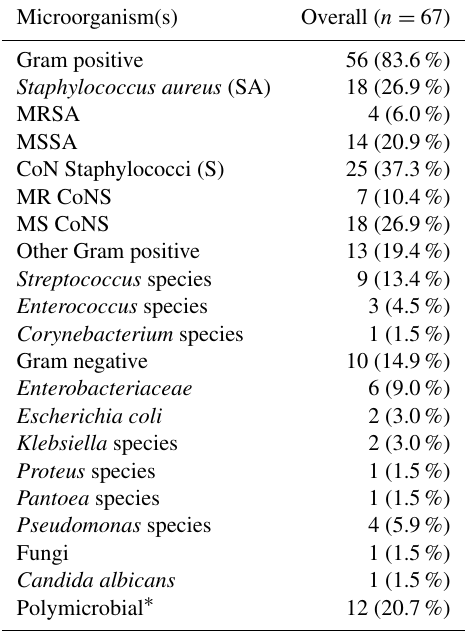
Table 1. Demographic and clinical information of the 58 patients included.